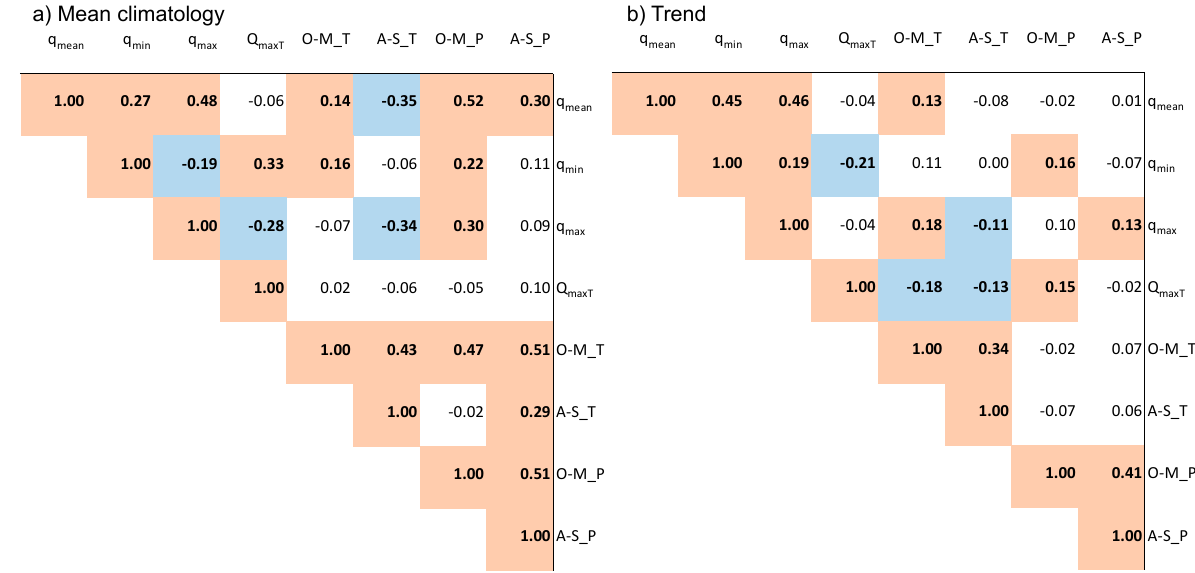
Figure 3. Correlogram of climatic and streamflow variables: ( a ) 1976 to 2005 mean climatology; ( b ) trends for available period. Both climatic and streamflow variables are averaged over the basins. The numbers on the plots are Kendall’s τ correlations, with significant correlations ( p < 0.1) indicated by bold numbers.